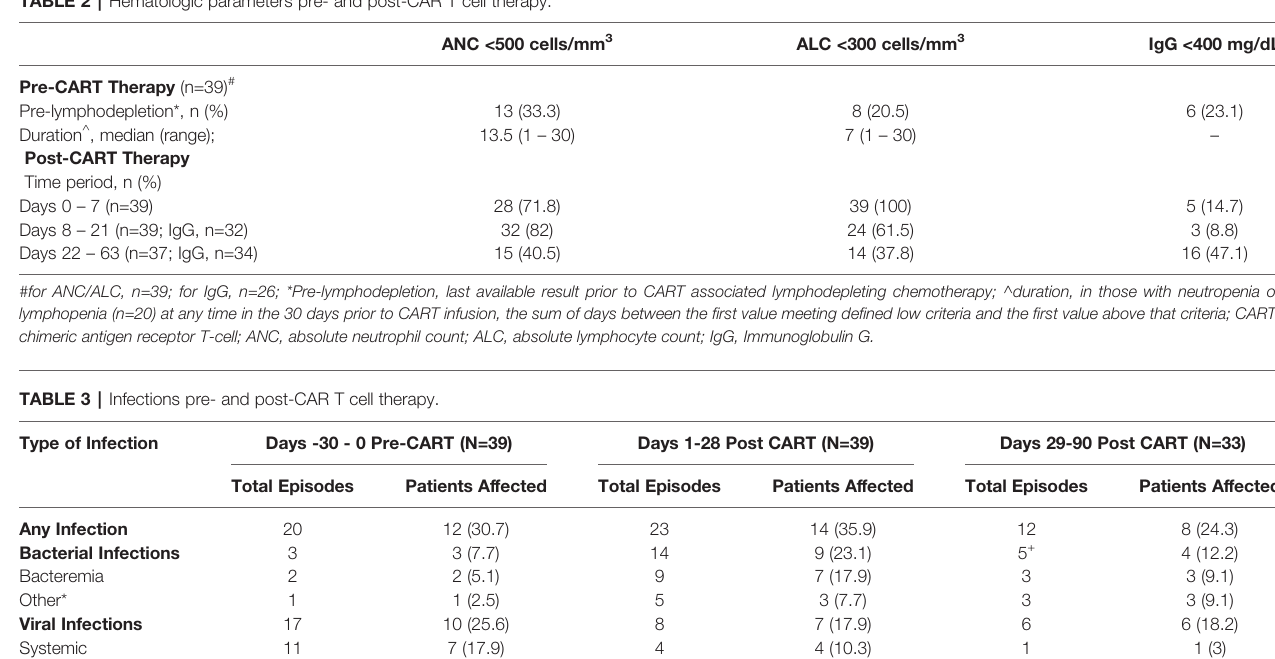
TABLE 2 | Hematologic parameters pre- and post-CAR T cell therapy.